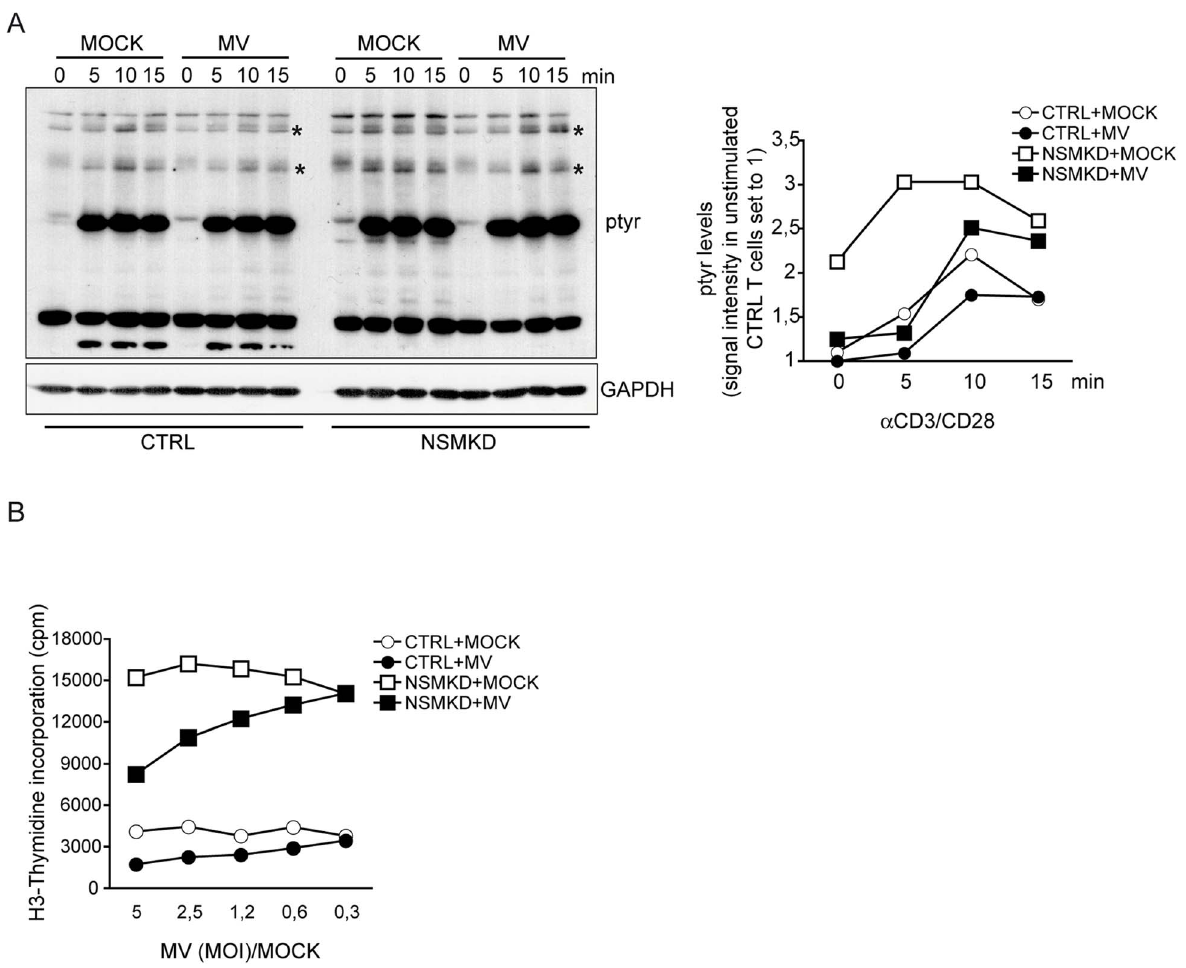
Fig. 6. NSM activation contributes to MV interference with T cell early activation and expansion. A. Overall tyrosine phosphorylation was determined at the time intervals indicated following a a˜CD3/CD28 activation in CTRL and NSMKD cells pre-exposed to MOCK or MV (MOI 1,2) by Western Blotting (where GAPDH detection served as loading control). p-tyr protein species detectably affected by MV interference are starred (*). Right: densitometric analysis of p-tyr profiles of all p-tyr species was performed for each individual lane, quantified using AIDA software and standardized to the signal intensities in unstimulated MOCK treated cells. B. Proliferation efficiencies of CTRL and NSMKD cells pre-exposed to MOCK (each: white symbols) or MV (each: black symbols) at the MOIs indicated (or corresponding protein amounts of MOCK) were determined after 48 h by incorporation of [ 3 H]-thymidine.